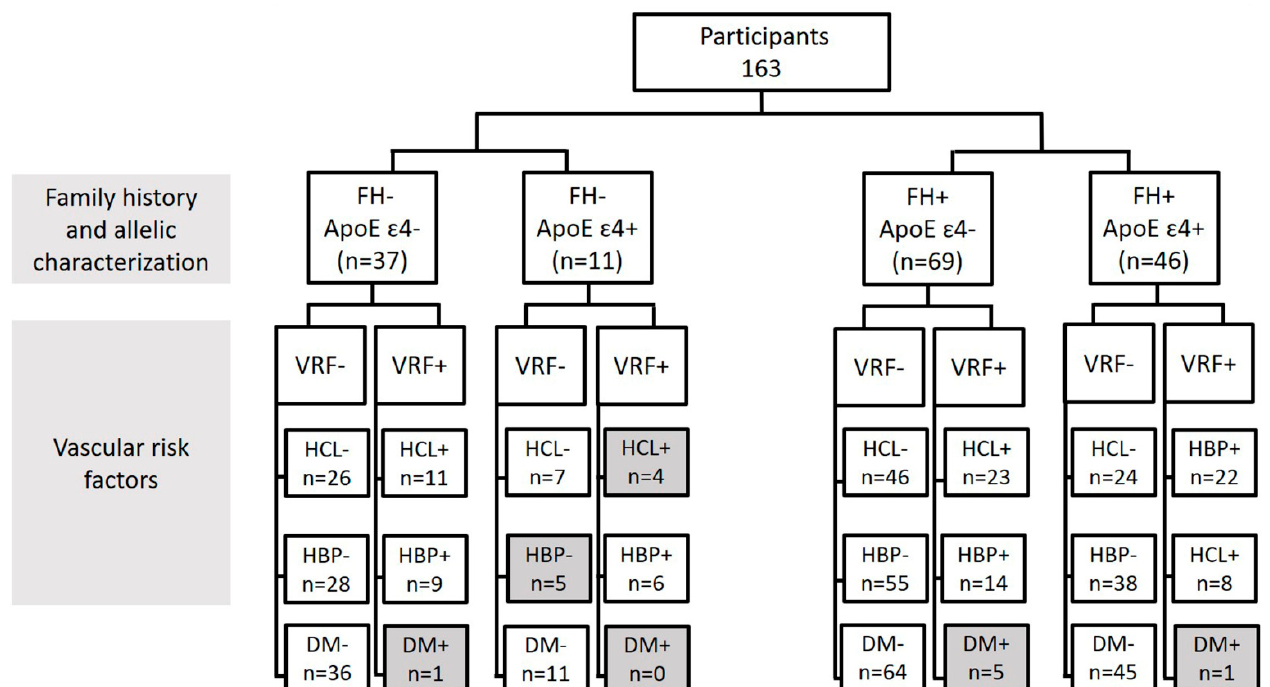
Figure 1. Flow chart of the subjects included in the study according to the different characteristics. (FH, family history; ApoE, apolipoprotein E; VRF, vascular risk factors, HCL, hypercholesterolemia, HBP, high blood pressure; and DM, diabetes mellitus). In gray, the groups discarded for having an n < 6 are shown.